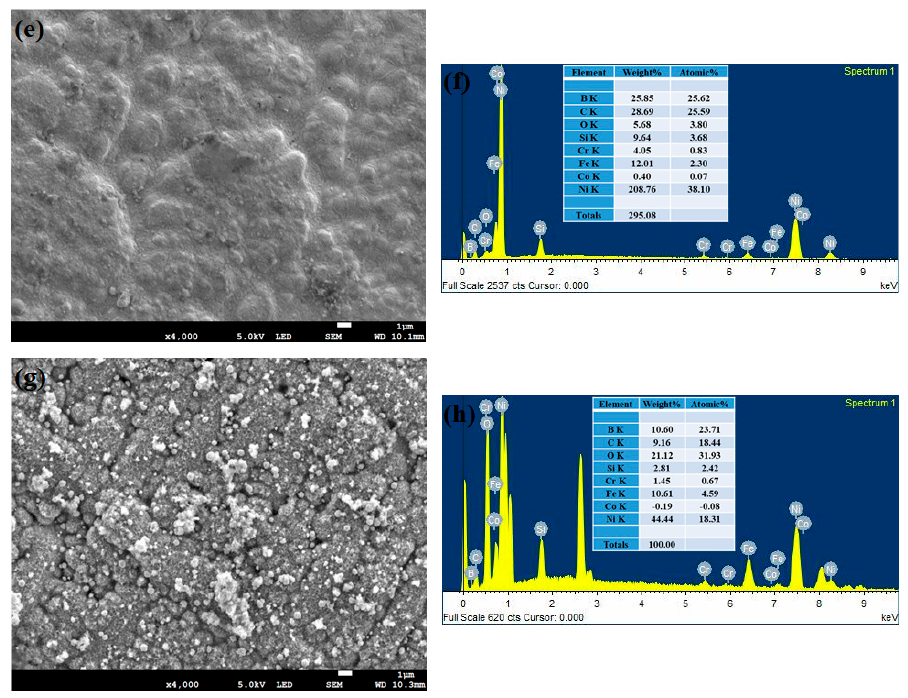
Figure 8. FESEM and EDS spectra of the corroded cladded samples treated at ( a , b ) 0 h, ( c , d ) 18 h, ( e , f ) 42 h and ( g , h ) 70 h. Table 4. The elemental compositions of both substrate and clad samples at different time